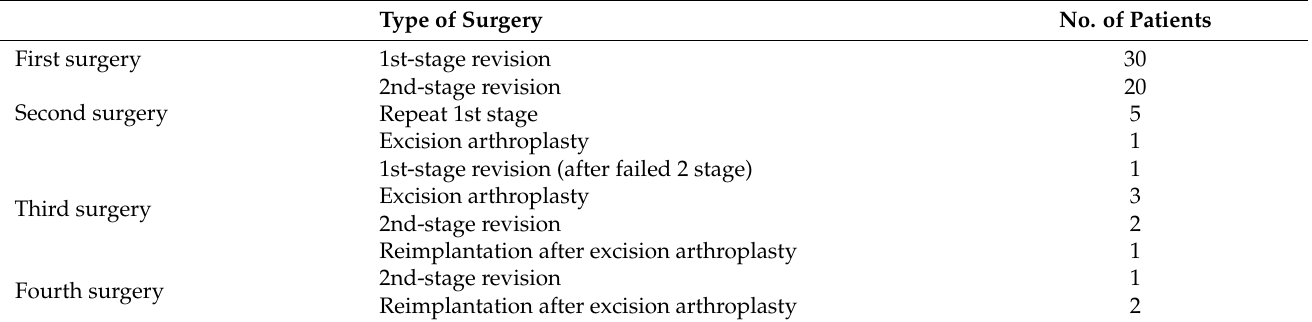
Table 2. Number and types of surgery in the study group.